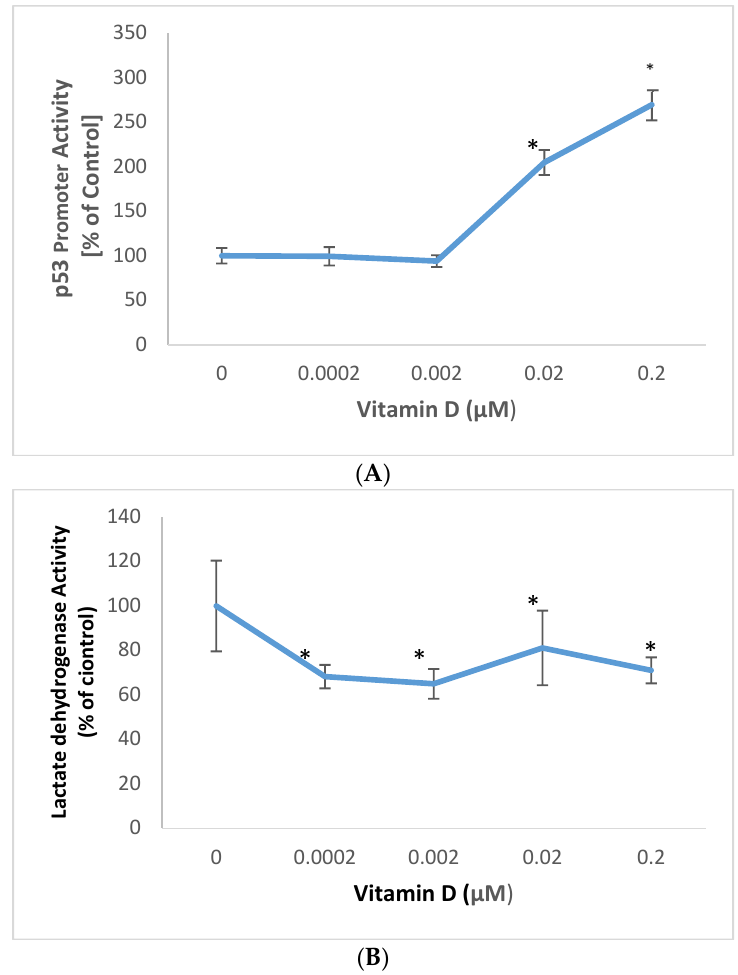
Figure 2. Effect of 1 α ,25-dihydroxyvitamin D3 (vitamin D) on p53 promoter activity ( A ), and lactate dehydrogenase activity (membrane damage) ( B ) in melanoma cells; error bars: standard deviation, n = 4; * = p < 0.05, relative to control.